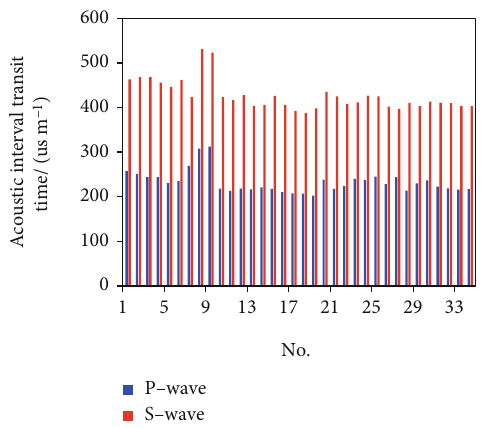
Figure 5: The acoustic interval transit time of samples.